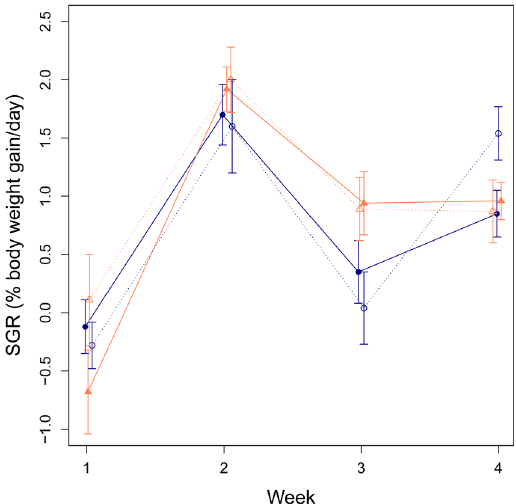
Figure 3. Specific growth rate (SGR) (% body weight gained/ day) over four time intervals, from tagging until the first CT max test (Week 1) and then weekly thereafter (Weeks 2–4). Solid lines and filled symbols represent the repeatability group (which underwent weekly CT max tests) and dashed lines and open symbols represent the sham group (which only had one CT max test in Week 4 and experienced sham CT max tests in Weeks 1–3). Females are represented by orange triangles and males by blue circles. Values are given as means ± s.e.m.